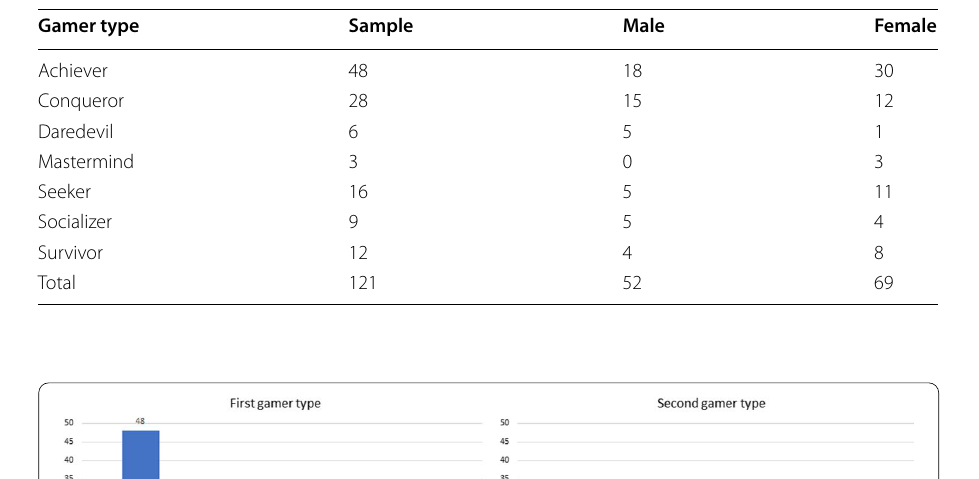
Table 2 Sample of